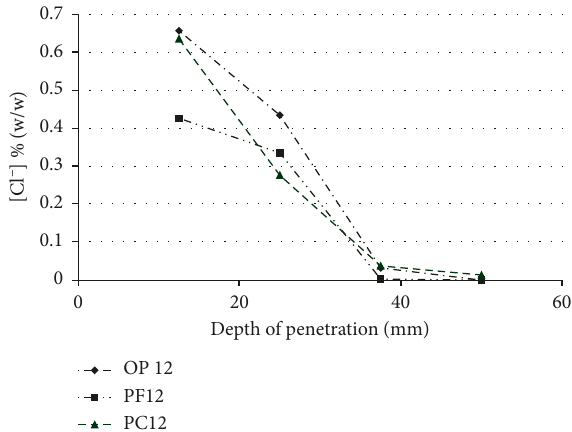
Figure 6: Results for chloride ingress versus depth from exposed surface for the test cements at 0.73 w/c